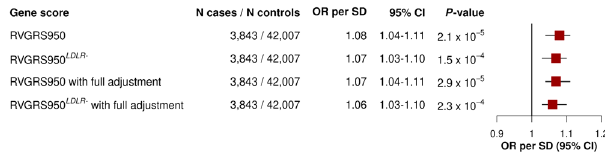
Fig. 7 Predictive effects of RVGRS950 and RVGRS950 LDLR − on CAD among UK Biobank participants. Odds ratios of RVGRS950 and RVGRS950 LDLR − (i.e., RVGRS950 without LDLR ) on CAD are shown for UK Biobank European participants. The same RVGRS with additional adjustment for a Framingham risk score and common variant genetic risk score (i.e., with full adjustment) are also shown. Squares represent the odds ratios that are expressed in terms of a 1 SD change in RVGRS. All odds ratios were calculated using a multivariable logistic regression model that was adjusted for age, age 2 , sex, and the fi rst 20 principal components of ancestry. Horizontal lines indicate the 95% con fi dence interval of the odds ratio. OR indicates odds ratio, SD indicates standard deviation, CI indicates from the top 950 discovery genes, and RVGRS950 LDLR − refers to rare variant genetic risk score from the top 950 discovery genes, excluding provided as a Source data fi le.